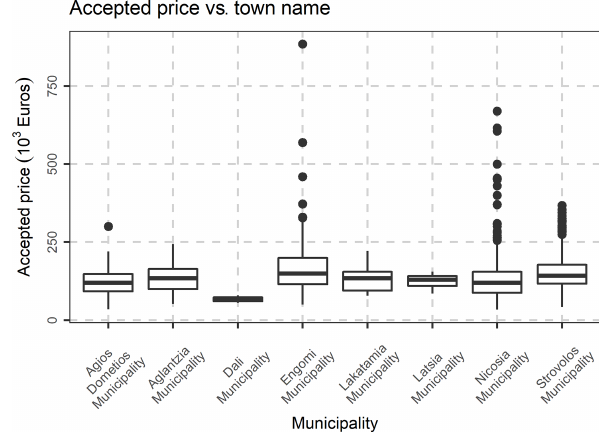
Figure 6. Histogram of Declared Price.